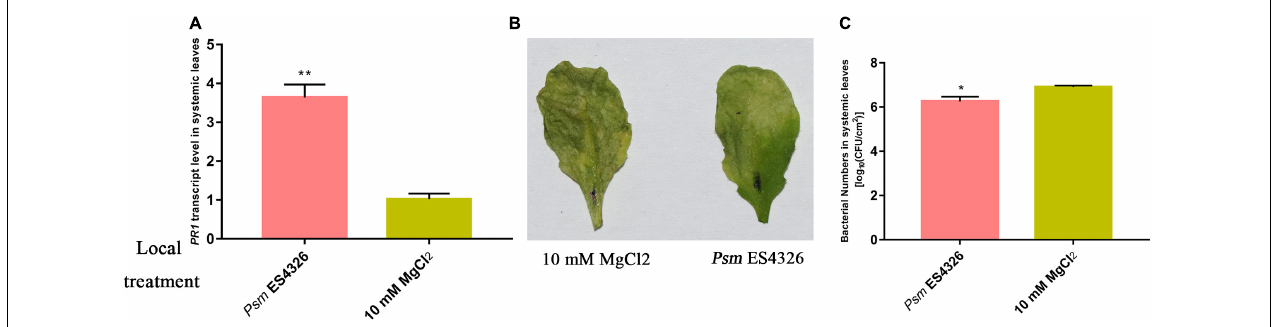
FIGURE 1 | Investigation of SAR. Col-0 plants were inoculated with virulent Psm ES4326 or 10 mM MgCl 2 . (A) Expression analysis of PR1 in systemic leaves of Psm ES4326-inoculated plants. Phenotype (B) and bacterial growth assay (C) of systemic leaves following secondary infection with Psm ES4326, after the initial infection of local leaves with Psm ES4326 or MgCl 2 . * p < 0.05 and ** p < 0.05 Data are presented as mean ± SE ( n = 3 or 4).